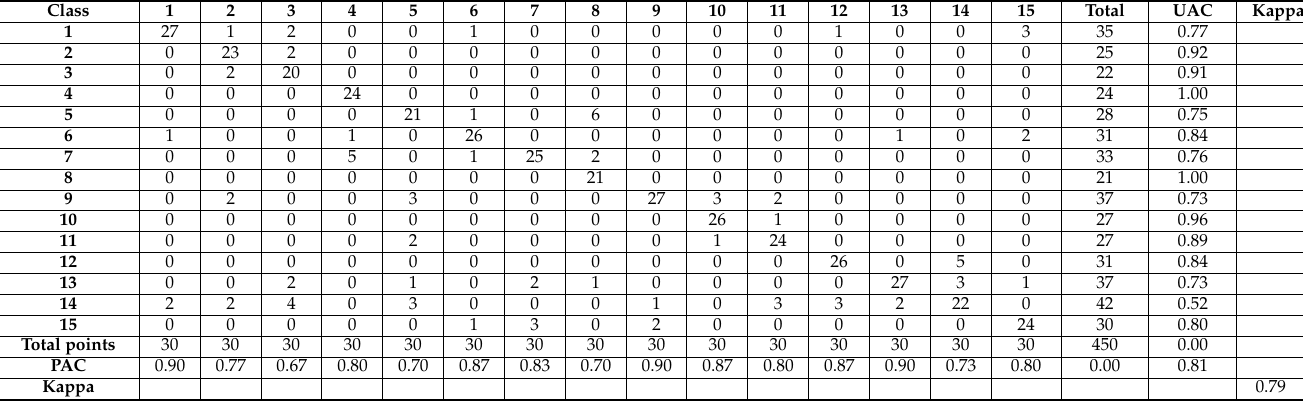
Table 2. Accuracy assessment metrics. The table shows the confusion matrix displaying the habitat classes and major benthic cover (1–15) and the accuracy metrics: user’s accuracy (UAC.); producer’s accuracy (PAC.) and kappa